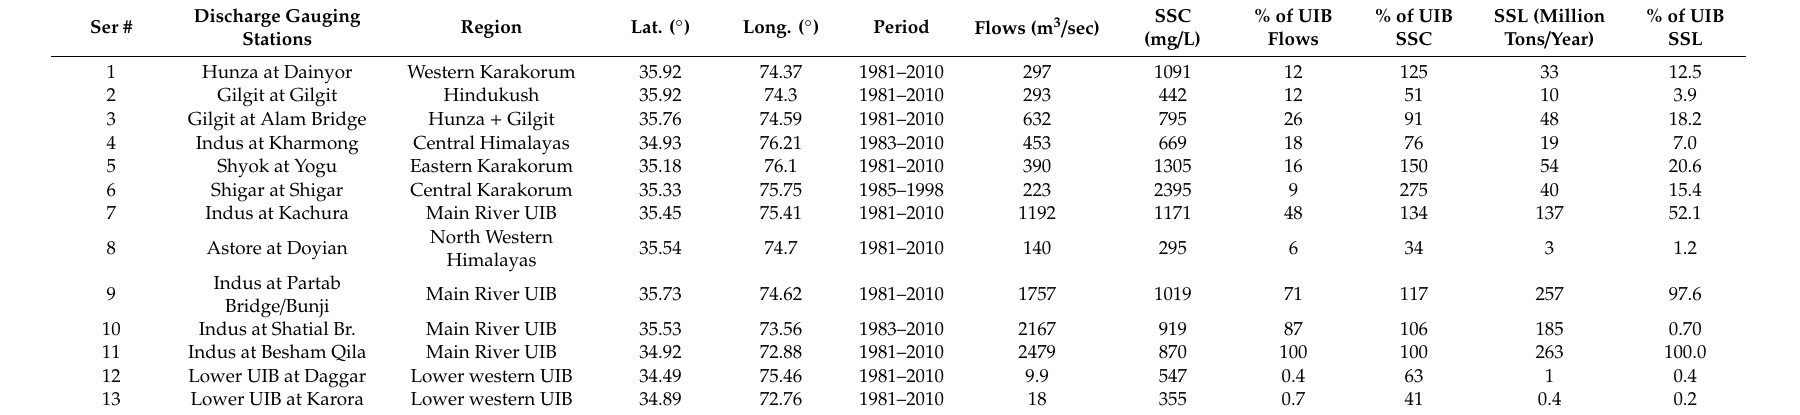
Table 2. Hydrological characteristics of discharge gauging stations in the Upper Indus Basin